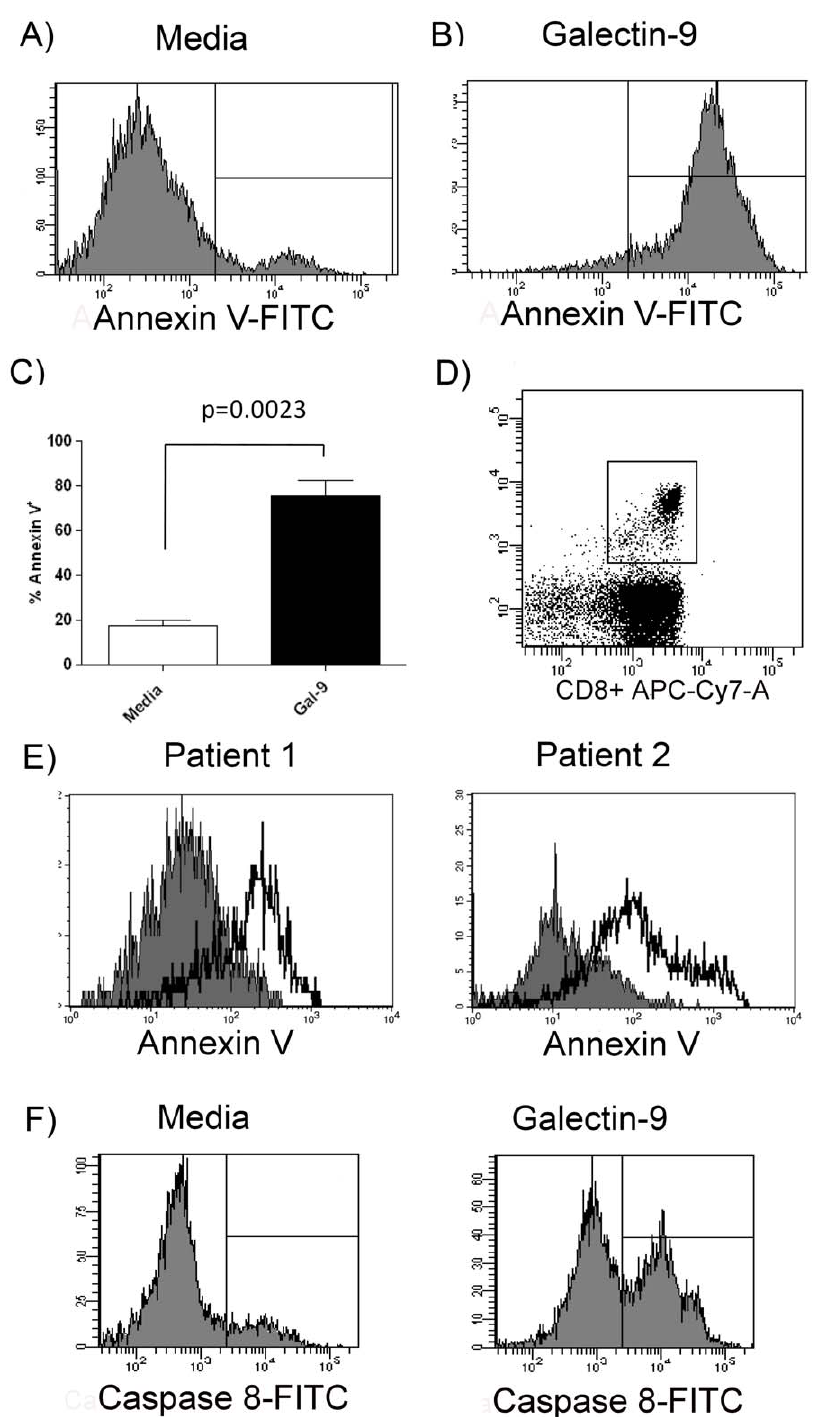
Figure 6. Galectin-9 induces apoptosis of HCV-specific CTLs through caspase-8 activation. CD8 + T cells clones specific for NS3:1406, NS3:1436 and NS5:2594 were incubated for 6 hours in media alone ( A ) or with 5 ug/ml of galectin-9 ( B ) followed by staining with Annexin V and 7- AAD. Representative histograms showing the percent of HCV-specific T cells staining with Annexin V following the indicated treatment. ( C ) Combined data for 5 CTL clones from different patients demonstrated an increase in Annexin V/7-AAD with galectin-9 treatment. P-values were calculated using the Wilcoxan matched-pairs signed rank test. ( D ) Plot showing NS3:1436-specific CD8 + T cells by pentamer staining ex vivo. ( E ) Annexin V staining of NS3:1436- specific CD8 + T cells from two HCV patients cultured for 6 hours with media (grey shading) or galectin-9 (solid line, no shading). ( F ). Galectin-9 induces T cell apoptosis through caspase-8 activation. Shown are PBMC from a HCV-positive patient treated for 1 hour with 5 ug/ml galectin-9 or media alone. A FITC-conjugated caspase-8 inhibitor that binds specifically to activated caspase-8 was added for the last hour of culture. Cells were then stained with anti-CD8 and 1436-pentamer and the percentage of HCV-specific T cells with activated caspase-8 was determined by flow cytometric analysis.